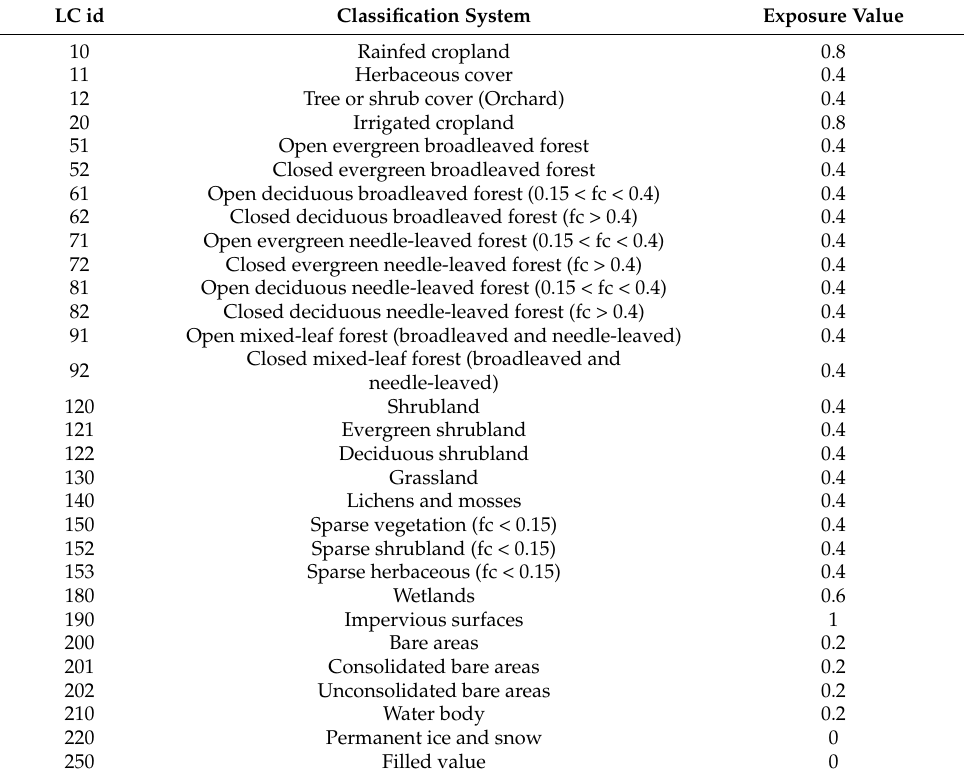
Table A1. GLC_FCS30 land cover classification system.